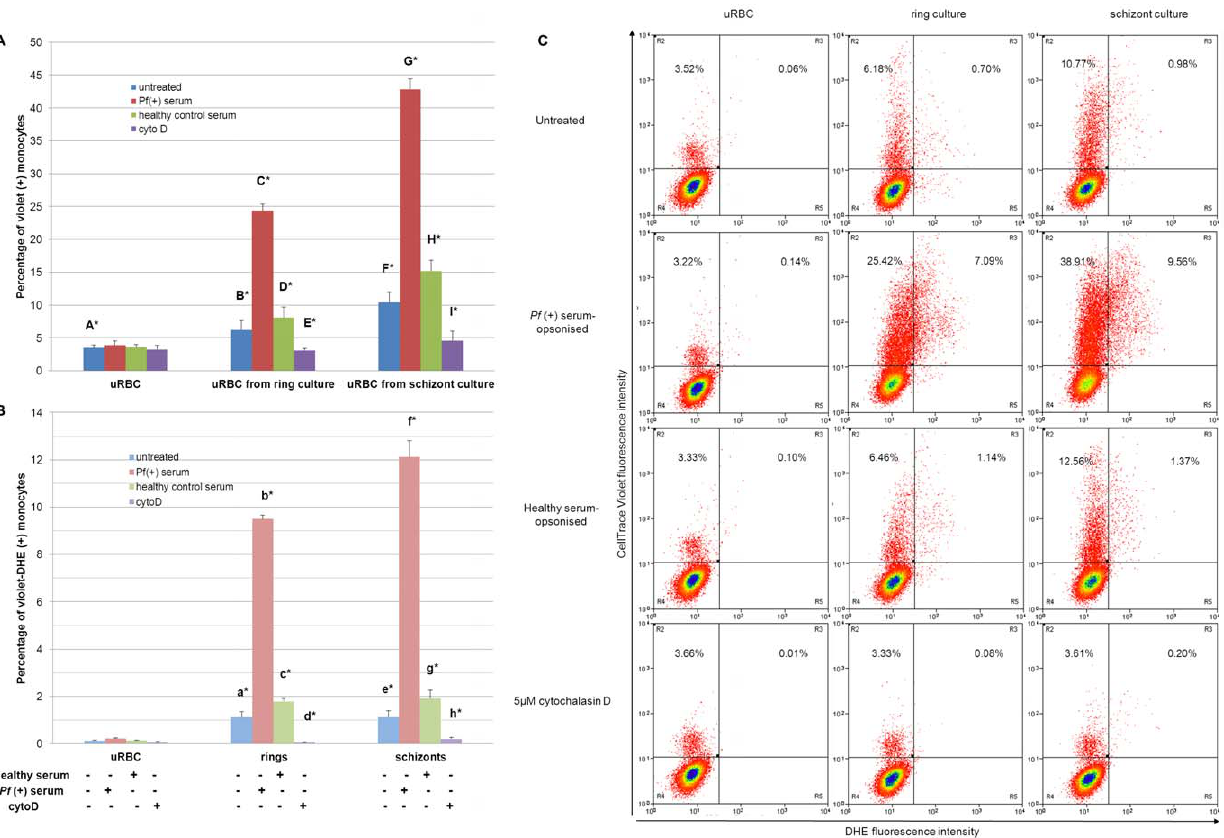
Figure 4. Phagocytosis of fresh uninfected erythrocytes (uRBC), ring-staged (ring culture) and schizont-staged cultures (schizont culture) at 10% parasitemia under different conditions by THP-1 monocytes. In standard conditions, incubation of erythrocytes with monocytes was carried out for 4 h at 37 u C with an E:T ratio of 1:100. To prevent phagocytosis, monocytes were pretreated with 5 m M cytochalasin D for 1 h before the phagocytic incubation of 4 h at 37 u C. To increase phagocytosis, erythrocytes were opsonised with serum from a Plasmodium falciparum ( + ) patient at room temperature for 30 min before incubation with monocytes. A) Monocytes that have engulfed at least one uRBC and B) monocytes that have engulfed at least one iRBC. Data expressed as mean 6 SEM. (B*vE*, p , 0.05; a*vd*, p , 0.005; A*vF*, C*vD*, F*vI*, G*vH*, b*vc*, f*vg*, p , 0.001; e*vh*, p=0.063; A*vB*, p=0.097; n=3 separate experiments, each in duplicates) C) Representative dotplots of the respective conditions when exposed to THP-1